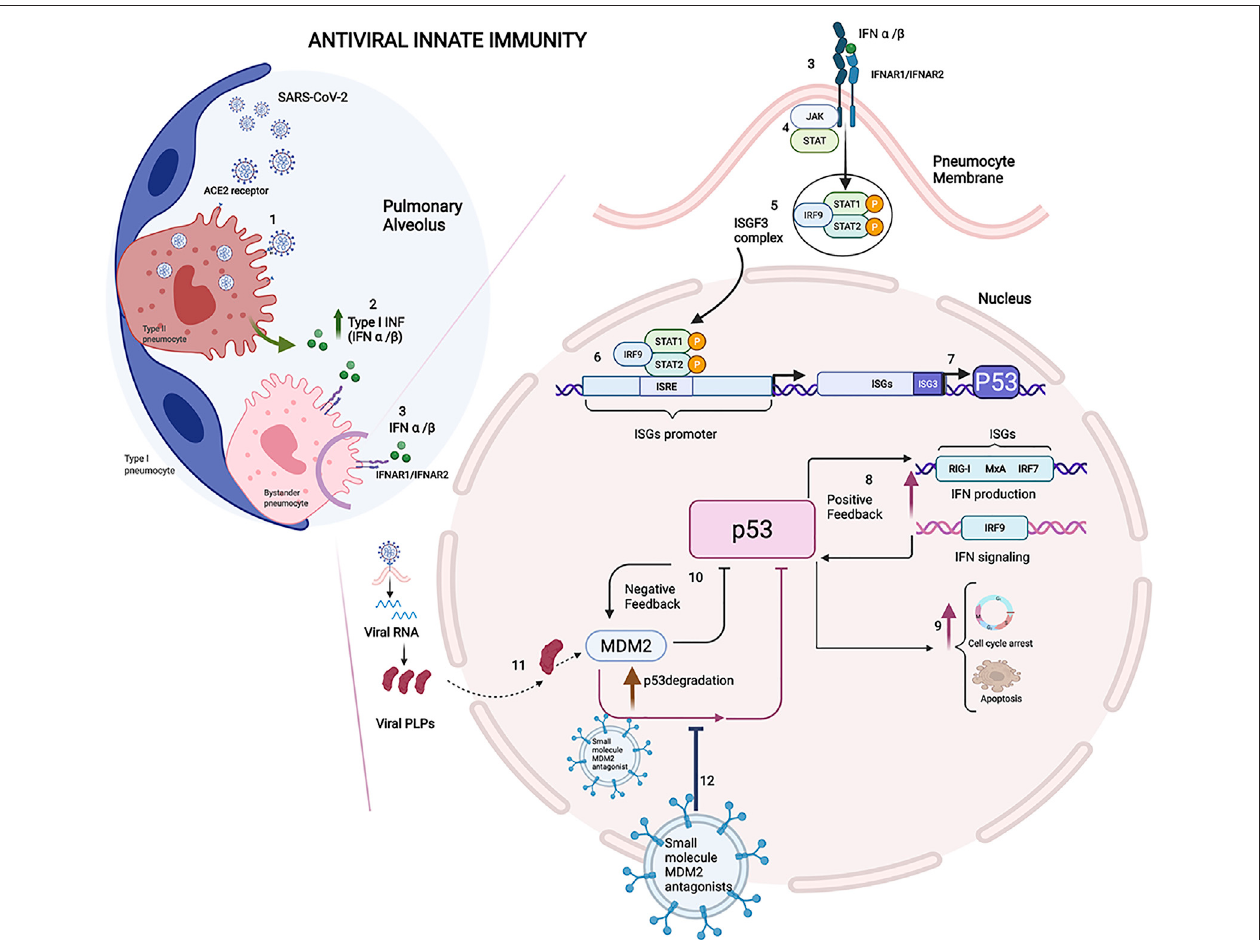
FIGURE 1 | Immune reaction in COVID-19: Innate immunity and the role of P53. 1 ) SARS-CoV-2 infects the type II pneumocytes by binding its S protein with the angiotensin-converting enzyme 2 (ACE2) receptor exposed on the surface of the pneumocyte membrane. 2 ) IFN α and IFN β play an antiviral role inside the infected cells byinhibitingviralreplication. 3 )Ontheneighbourcells,IFN α andIFN β bindtheirreceptorsIFNAR1andIFNAR2. 4 )ThesignaltransductionresultsinactivationoftheJAK- STAT signalling pathway involved in IFN-dependent antiviral defence. 5 ) The phosphorylated STAT1/STAT2 proteins form a heterotrimeric transcriptional factor with IRF9 known as the IFN-stimulated gene factor 3 (ISGF3), which translocates to the nucleus. 6 ) ISGF3 ties the IFN sequence response elements (ISREs) contained withintheIFN-stimulatedgenes(ISGs)promoter,anditenhancesthetranscriptionofthedownstreamgenesinvolvedinIFNantiviralresponse(PlataniasandFish,1999). 7) ISREs is included in the P53 gene promoter, and ISGF3 was proved to induce the expression of P53, whose protein level increases during the antiviral immune response. 8 )P53proteinactives IFNproduction andsignalling modulatingthepathway members,suchasIRF9, withpositivefeedbackintheearlystagesofinfection. 9 ) In the later stage of infection, p53 could thwart the viral spread leading to apoptosis in infected cells (Muñoz-Fontela et al., 2008). 10 ) The level of p53 is controlled by E3 ligase murine double minute 2 (MDM2), and the MDM2-p53 interaction decreases the p53 transcription factor and downregulates mdm-2 gene expression creating a negativefeedbackmechanism(Wuetal.,1993). 11 )Viralpapain-like proteases (PLPs),acysteine proteaseessentialtoprocesstheviral proteins, suppresses theinnate immunitybystabilizingthecellularoncoproteinMDM2andinducingthedegradationofp53. 12 )Thetherapeuticstrategyconsistsoftheadministrationoftheextracellular vesicles loaded with small-molecule MDM2 inhibitors to block the protein-protein interaction between p53 and MDM2. Their ability to protect p53 from degradation makes the small molecules MDM2 inhibitors an attractive drug that, once loaded in the EVs, could be delivered to the targeted district, reducing the pro-in fl ammation state in the early stages of viral infection. The Figure was created with